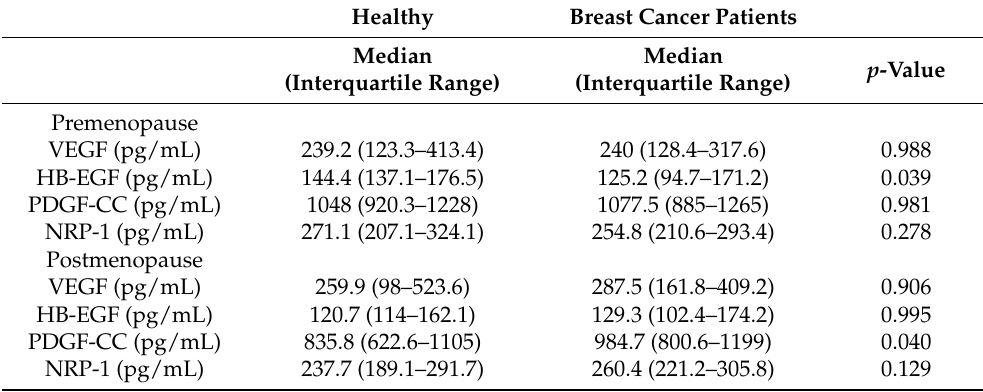
Figure 4. Box plots of VEGF, HB-EGF, PDGF-CC and NRP-1 serum levels among patients with different molecular subtypes according to their BMI status. Table 5. The median concentrations (interquartile range) of the examined molecules in premenopausal and postmenopausal